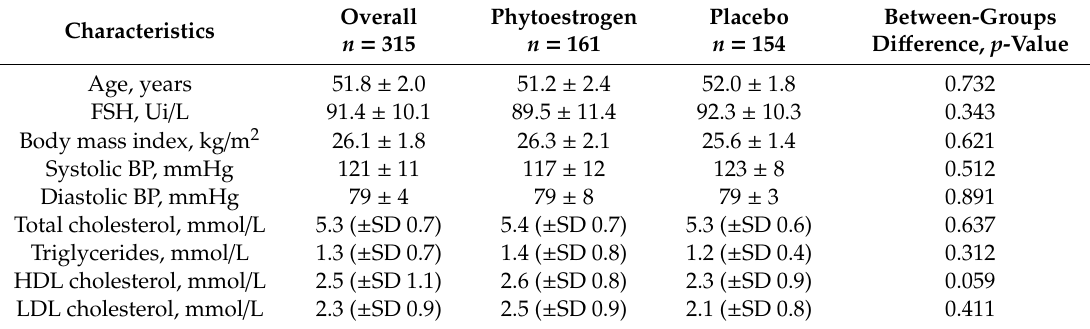
Table 1. Clinical and laboratory data of early postmenopausal study participants at